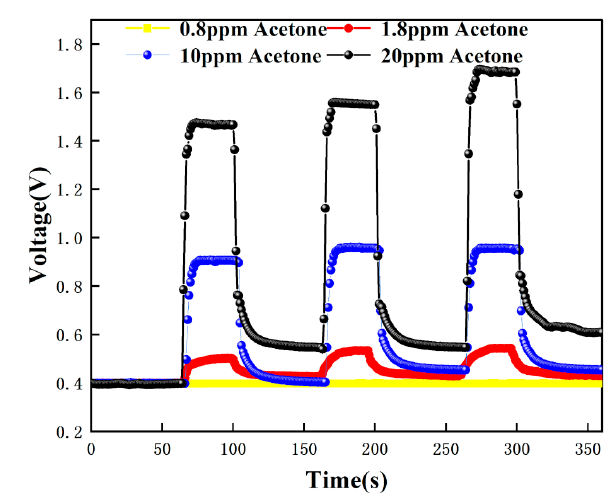
Figure 23. Response test results for different concentrations of acetone.